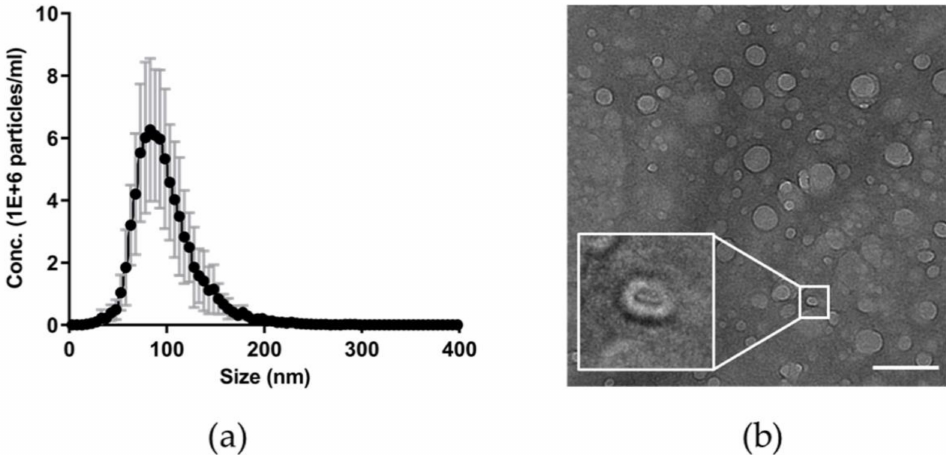
Figure 2. Characteristic features of plasma nanoparticles. Nanoparticle tracking analysis (NTA) was performed using a ZetaView twin instrument. ( a ) The average concentration of particles in plasma is 2.8 × 10 12 /mL with a heterologous hydrodynamic size range of 20–400 nm and a mean particle size of 94 nm in water. HC samples, n = 7. Points (black) represent the mean and the error bars (grey) represent the standard deviation (SD). ( b ) Transmission electron microscopy (TEM) identified intact, spherical vesicles in patient plasma with a heterogeneous size. Some of these particles displayed the classic cup-shape morphology typical of negatively stained BEVs (inset figure). Scale bar 500